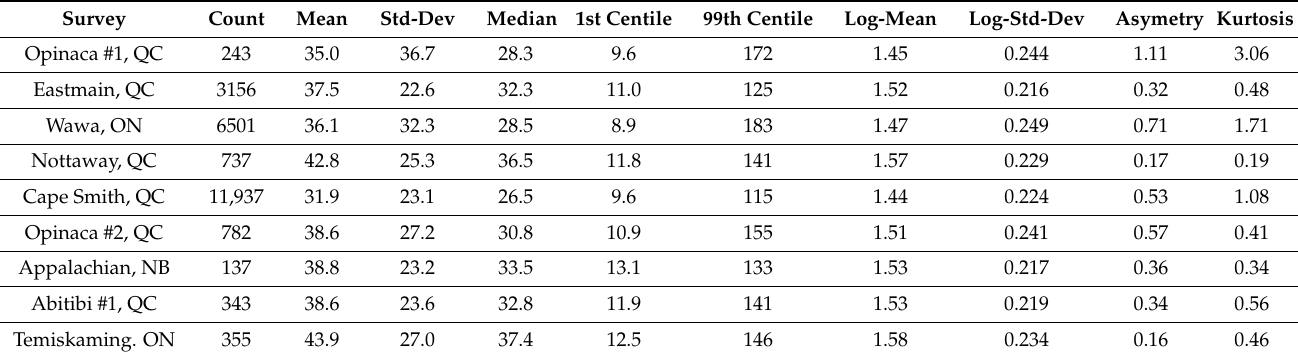
Figure 1. Location of the various till sampling survey used in the current study. Numbered projects refer to surveys listed in Table 1, in the order they are listed. Table 1. Statistics on the measured long axis of gold grains from lodgment tills of 16 recent sampling programs. Grain size distribution is assumed as log-normal; the log-mean, log-standard deviation, asymmetry coefficient (skewness) and kurtosis were calculated on the logarithm (Log 10 ) of grain size. The constancy of the distribution among projects is discussed in the main text. Still, due to the large number of grains involved, the difference between the means is still statistically significant according to a Student’s t-test, and cannot be caused by the variance of each population.